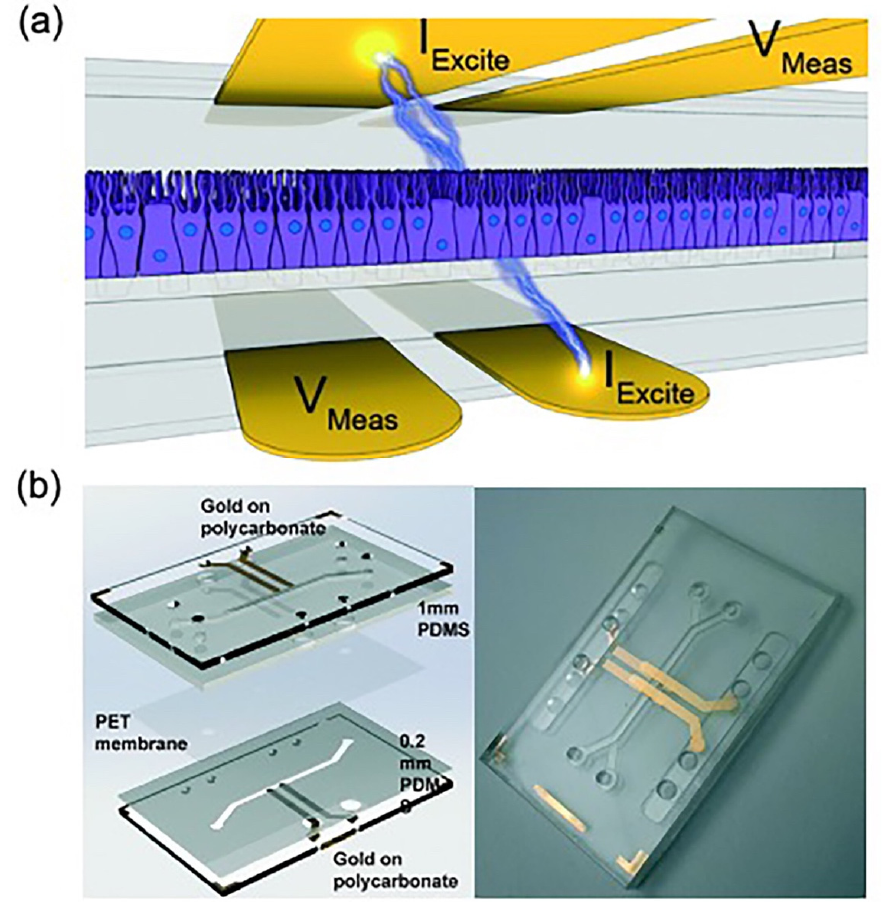
Figure 3. Microengineered human airway-on-a-chip with TEER biosensor: ( a ) Schematic view of the TEER chip’s working principle. ( b ) Photograph of the assembled TEER chip. Reproduced with permission from [53] .